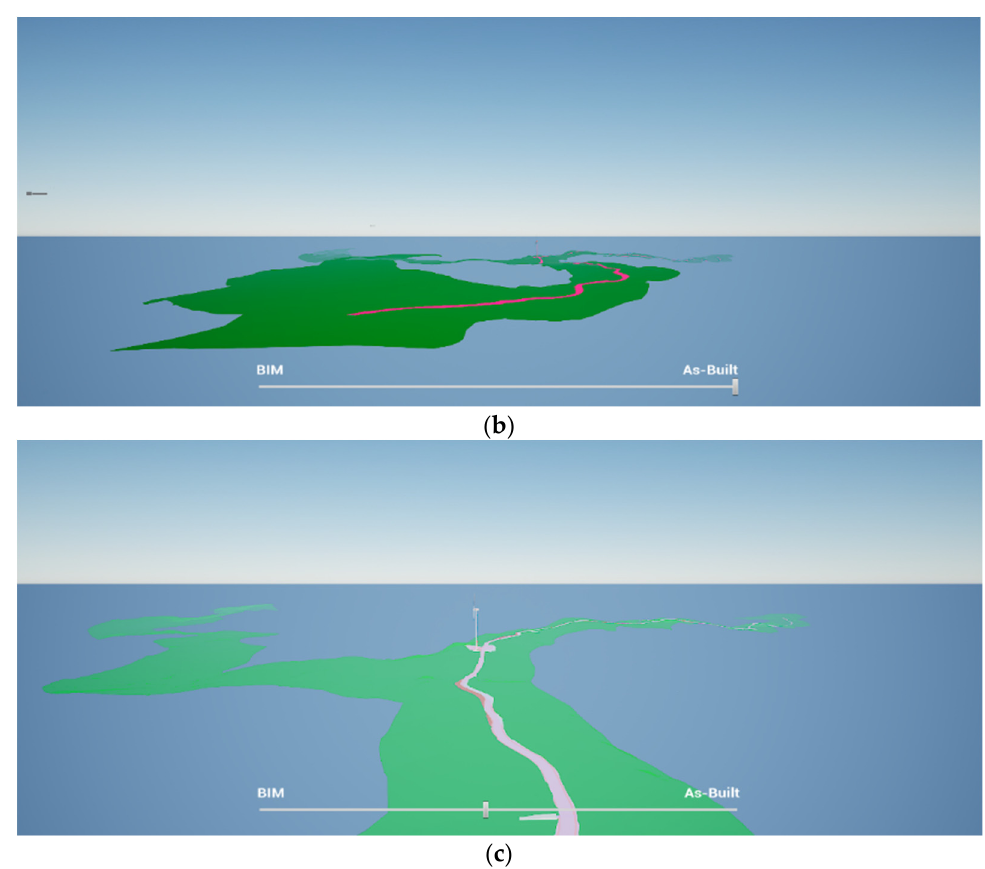
Figure 7. The application with the slider tool in different stages: ( a ) BIM model (from the design phase); ( b ) as-built model; ( c ) contrast of both.